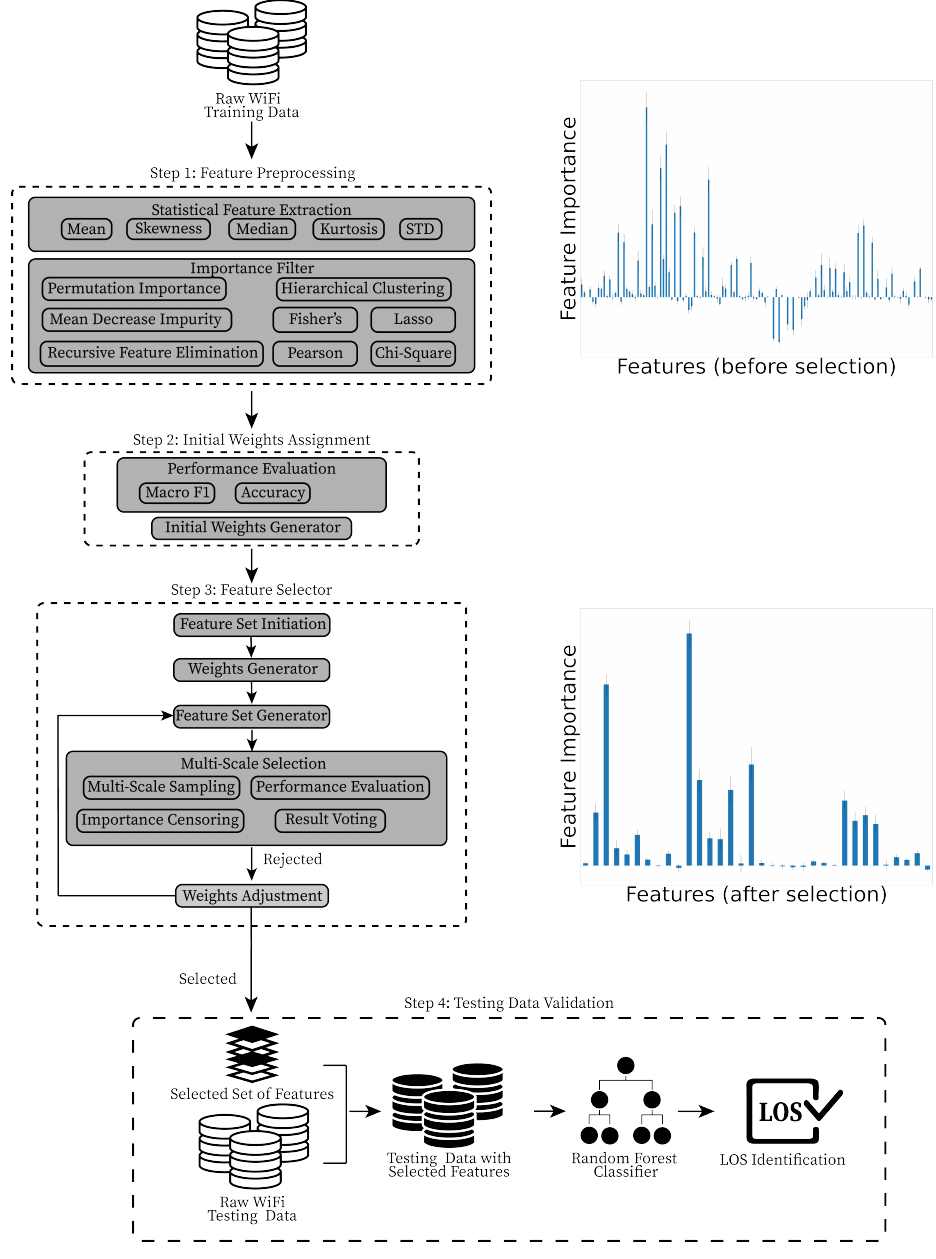
Figure 2. The architecture of our proposed framework. As illustrated in the bar plot, our proposed framework greatly reduced the number of features while keeping the most informative